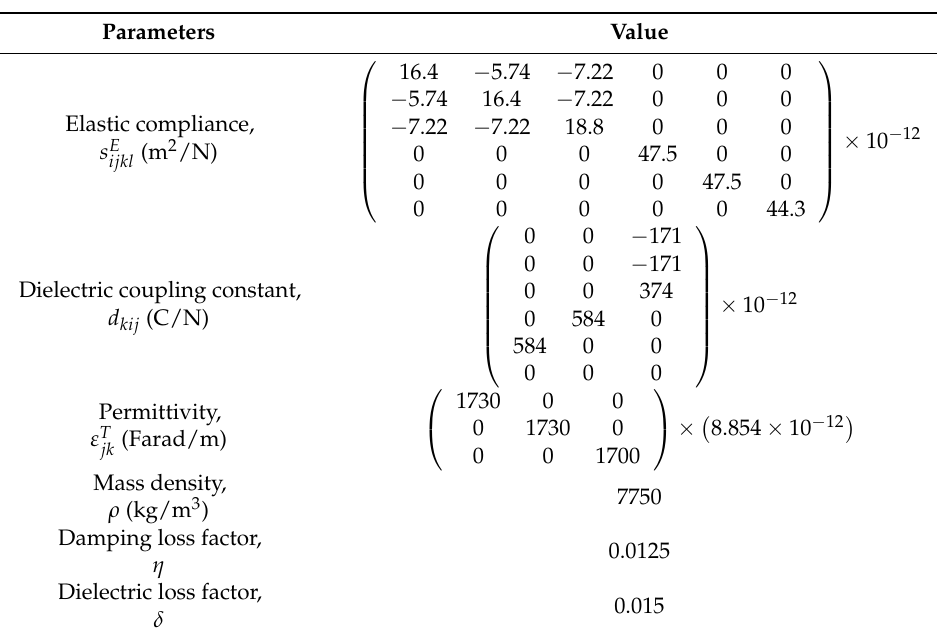
Table 2. Properties of the PZT-5A patch.